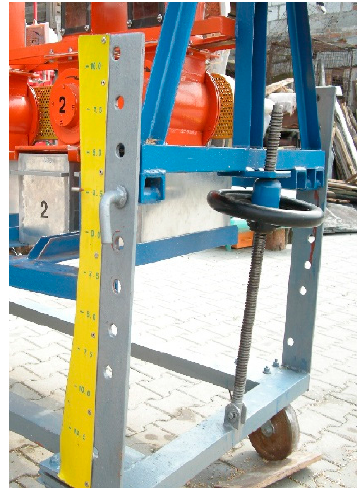
Figure 2. Indicator and control mechanism of the sieve unit inclination angle.